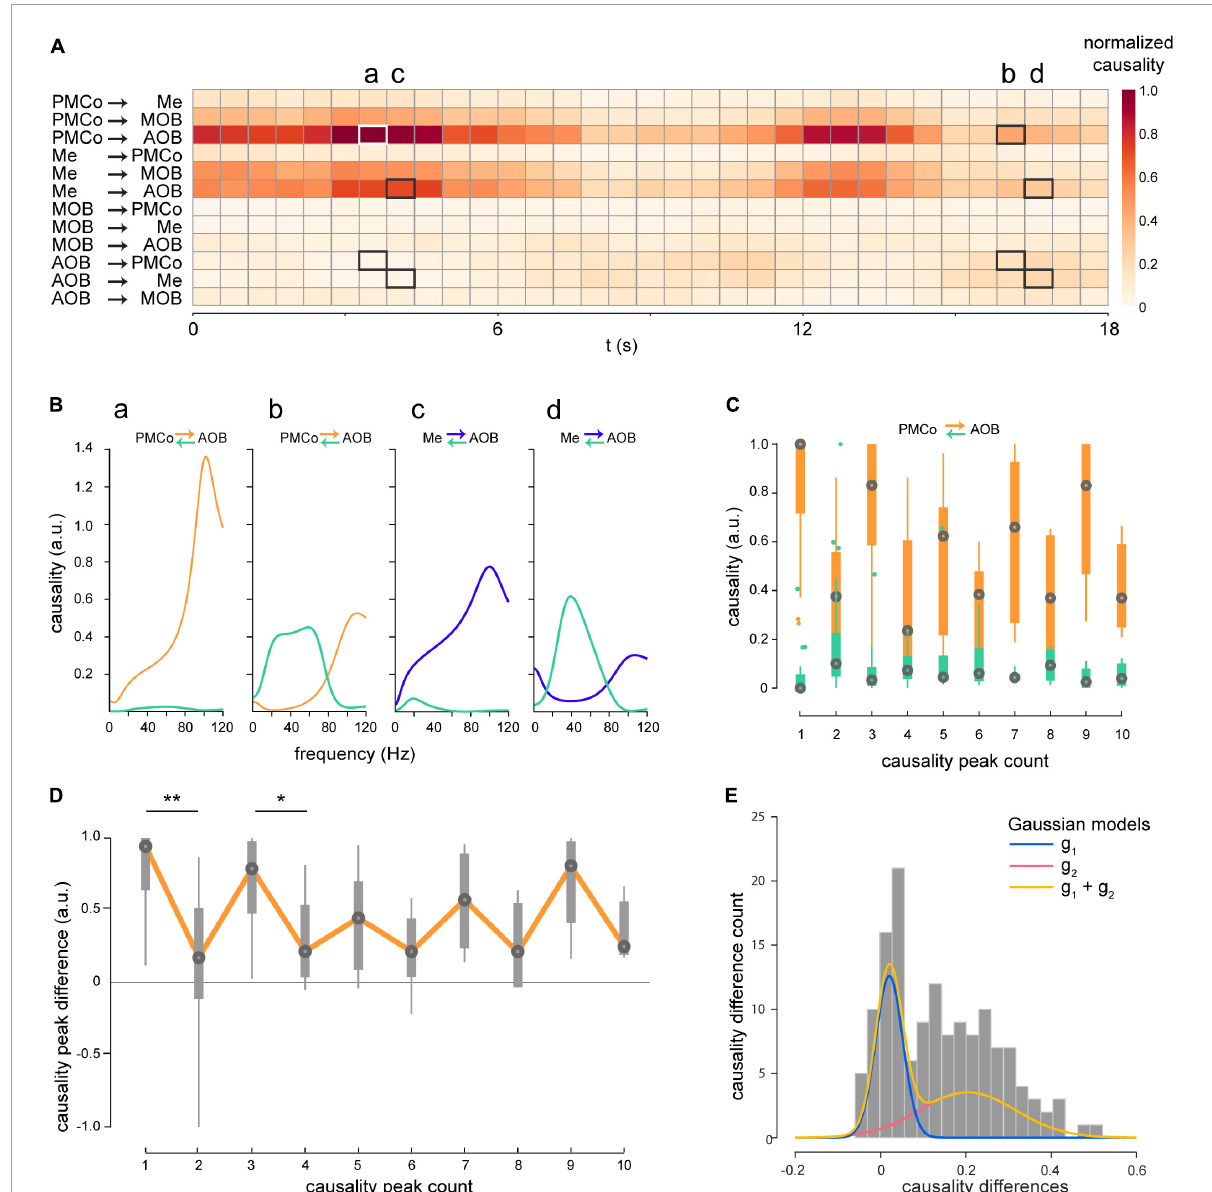
FIGURE3 Time-course of the Granger’s causality. (A) Heatmap of a representative case of the causal values in the time domain within pairs of brain areas triggered by male-soiled bedding in session 2. (a to d marks) (B) Specific segments marked in (A) were analyzed in the frequency domain: (a) PMCo → AOB, (b) AOB → PMCo, (c) Me → AOB, (d) AOB → Me. (C) Boxplot of causality peaks in both directions on consecutive epochs for diverse exploration segments. Note the different positions of the aligned orange and green boxplot as indicative of the difference between causal peaks for both directions. (D) Boxplot of the differences between causal peaks derived from (B,C) . Boxes represent the difference between consecutive peaks of causality. The orange line is intended to illustrate the cyclic progress of the difference in the causal relationship between PMCo and AOB. The statistical comparisons are made among pairs of consecutive values (* p < 0.05, ** p < 0.01). (E) Gaussian models of the distribution of the differences in causal values between PMCo and AOB are represented in (B) . The orange curve defines the bimodal model, and the blue and red curves the constitutive unimodal models. Akaike’s information criterion confirmed the choice of a dual Gaussian model to represent the data.